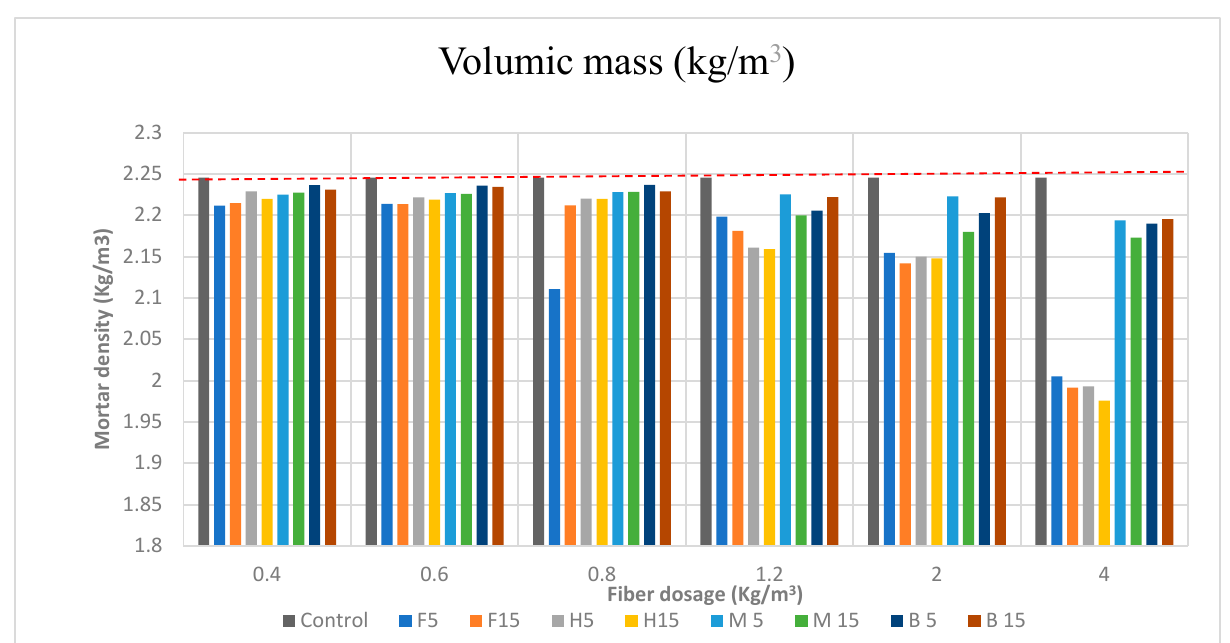
Figure 5. Mortar density (kg/m 3 ) for every fiber dosage. The sample control density is indicated by a dashed red line. Table 7. Density (kg/m 3 ) mean value measured on three specimens for each mortar mix. CS: